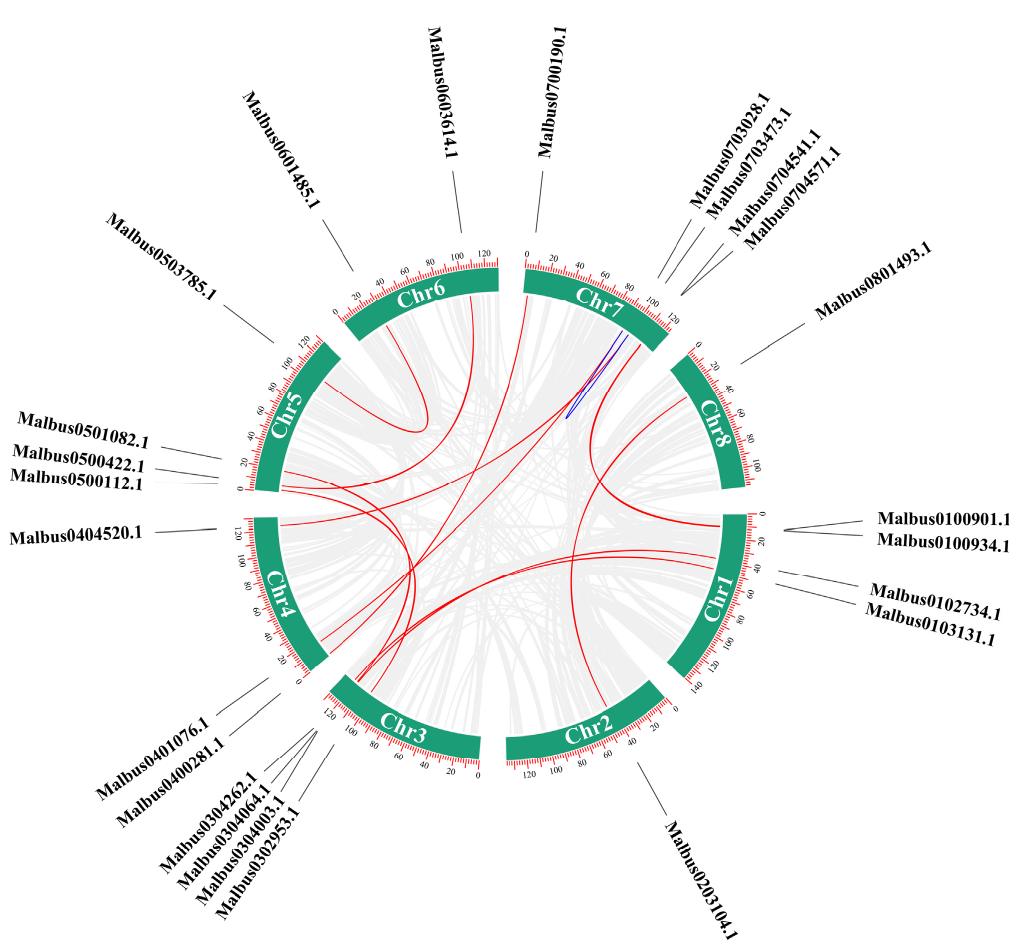
Figure 6. Synteny analysis of the MaRab genes from M. albus . The red lines indicate gene pairs between different chromosomes, while the blue lines are on the same chromosome. In the figure, the eight M. albus chromosomes are represented by closed circles in green. The numbers and scales on the chromosomes represent the position of the genes on the chromosomes. The ID numbers of the genes are located at the periphery of the chromosomes.